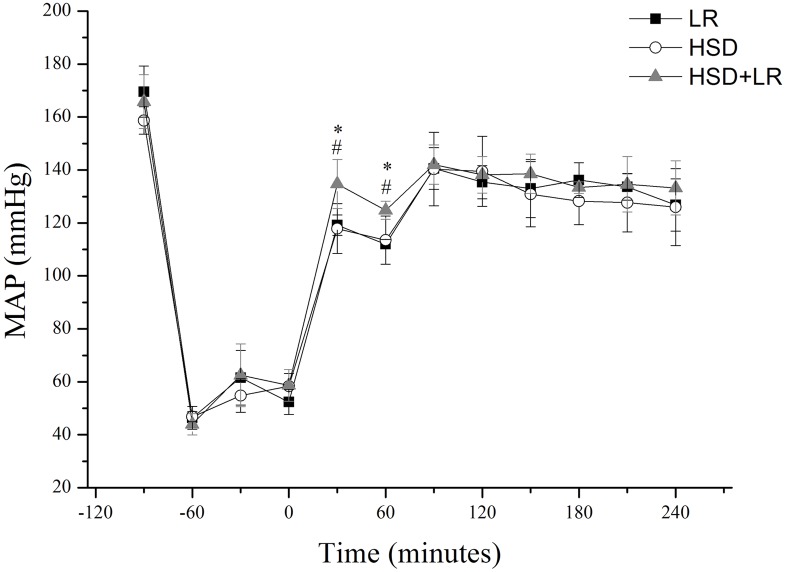
MAP in the LR, HSD and HSD+LR groups, measured at different time intervals.Pre-hospital resuscitation (0-60min) from hemorrhagic shock respectively with (1) 40ml/kg lactated ringers at a constant rate of 20 ml/min (LR group), (2) a bolus of HSD (4ml/kg) over a fixed interval of 2 min (HSD group), or (3) an initial bolus of HSD (4ml/kg) with a continued infusion of 40ml/kg Lactated Ringer (HSD+LR group). Subsequently all groups were injected with lactated ringers in in-hospital (60-90min) until the MAP reached 85% of the baseline level. *P<0.05 vs LR (black square); #P<0.05 vs HSD (open circle); &P<0.05 vs HSD+LR (shaded triangle). n = 7 for all groups.